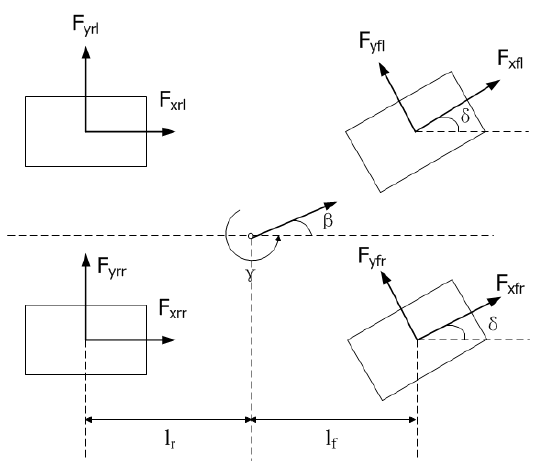
Figure 1. Four-wheel model of vehicle dynamics.